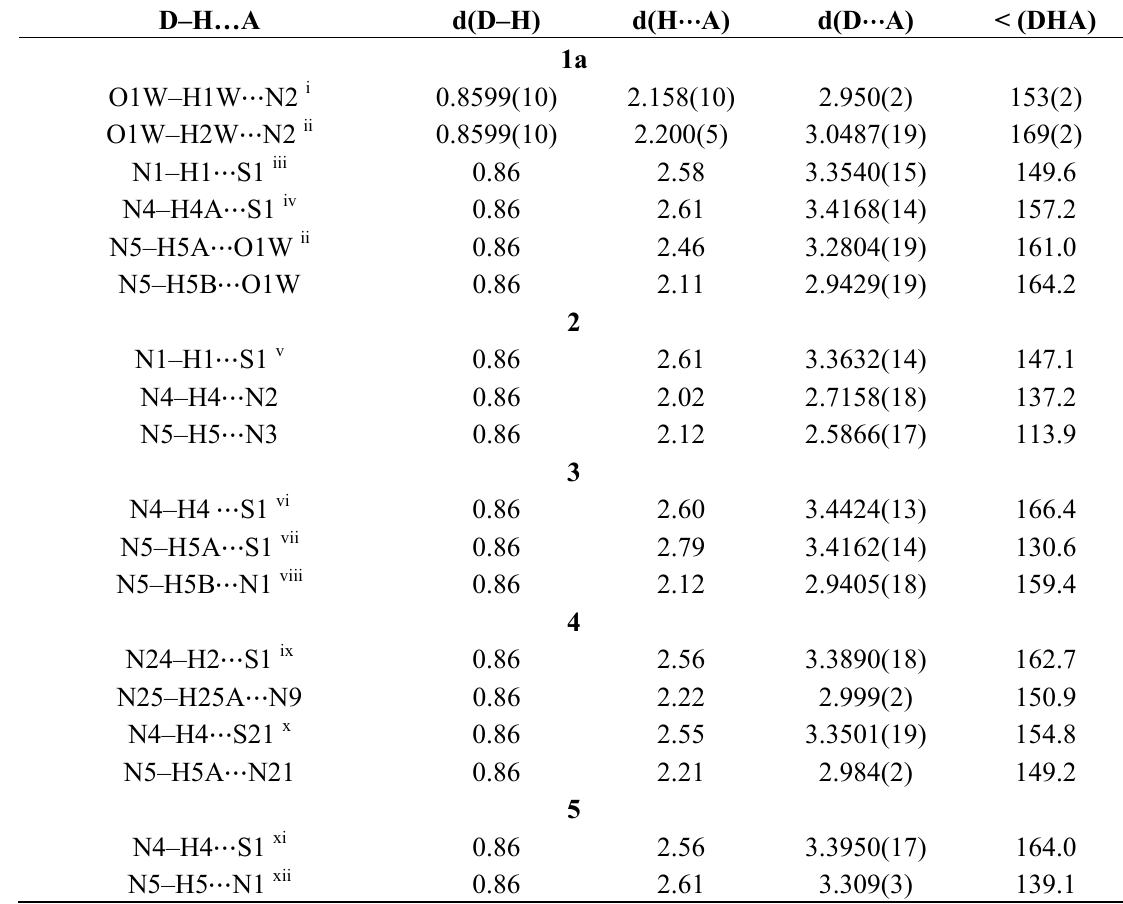
Table 1. Hydrogen bonds geometric parameters (Å, °) for ImT·H 4ImBzT ( 3 ), 4ImBzTM ( 4 ) and 4ImBzTPh ( 5